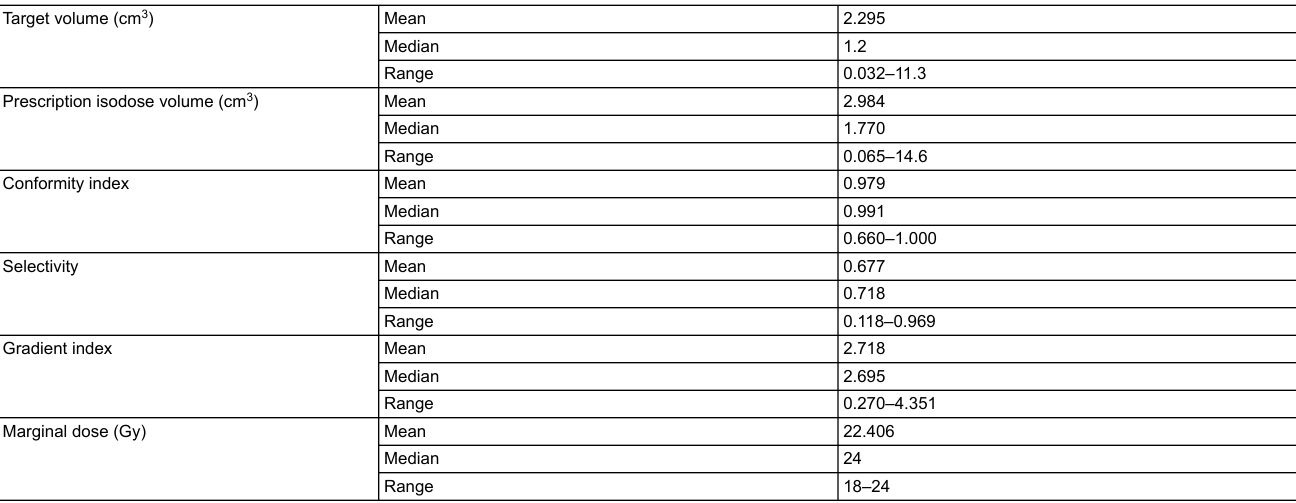
Table 3: Gamma knife radiosurgery dosimetric data (n total =